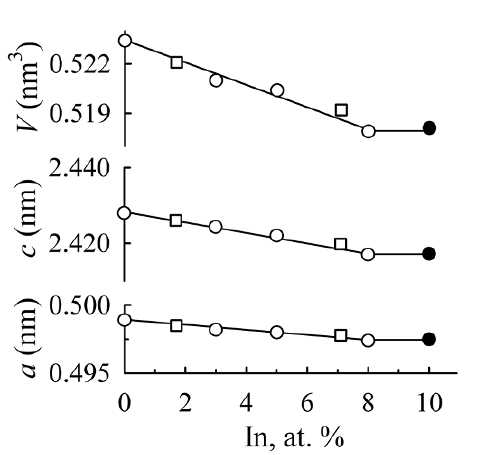
Figure 2. The lattice parameters and the unit cell volume V vs . the In content in the solid solution based on ErCo – single phase, close – 3-phases; square - the single crystal